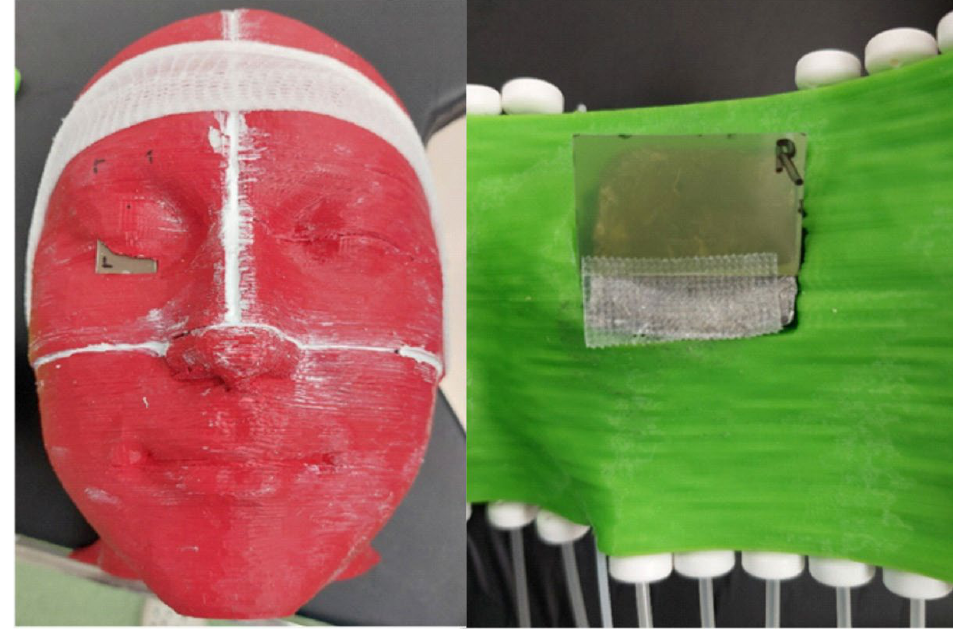
Figure 10. Gafchromic EBT3 film detectors. On the left side, the area of the eye lens, on the right side, the area of the eyelid surface.